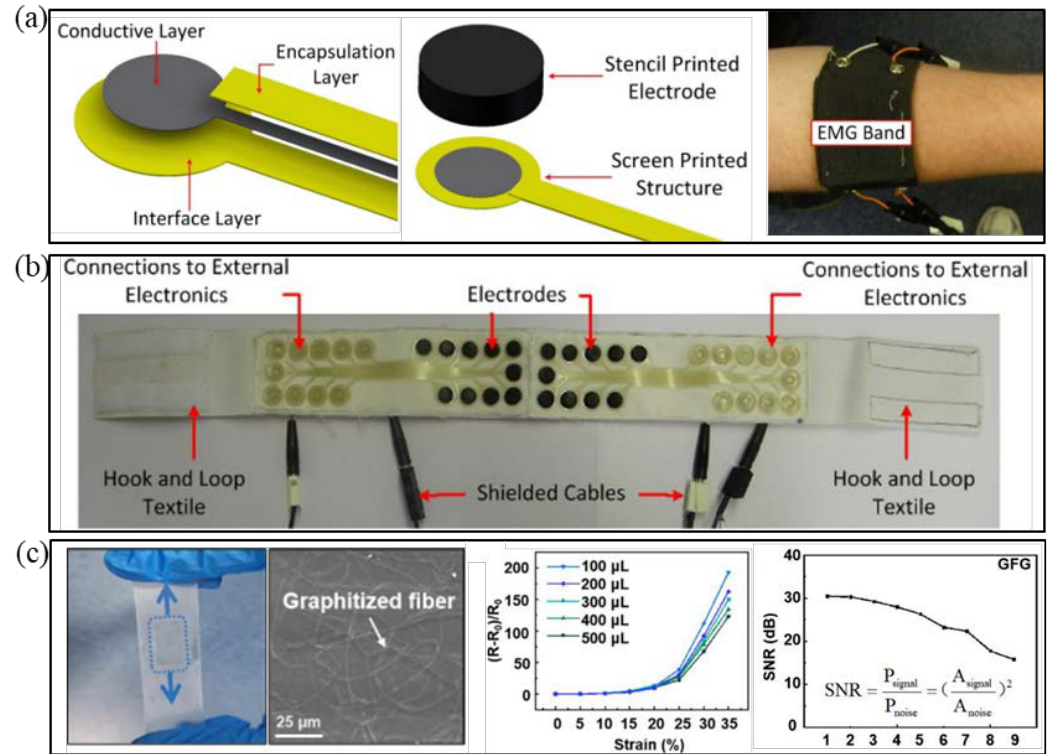
Figure 3. ( a ) Schematic diagram of the details of electrode sites in textile hand band. ( b ) Textile headband for EMG and EOG monitoring. ( a , b ) are reproduced with permission from [1]. Copyright 2014, Elsevier. ( c ) Photograph and SEM image ( left ) of the semi-embedded GFG. And resistance change of the semi-embedded GFG as a function of uniaxial stretching strains in middle. And SNR of sEMG detected by GFG/SEBS versus use times ( right ). Reproduced with permission from [26]